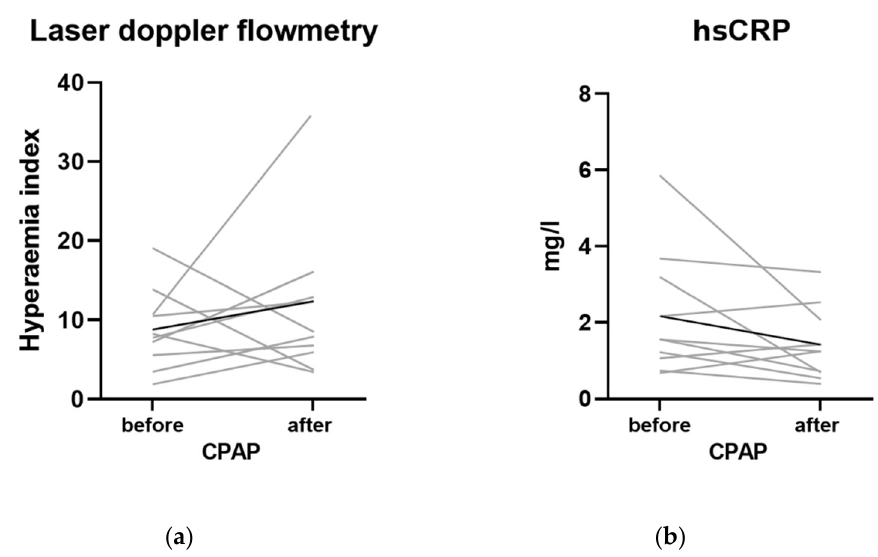
Figure 7. ( a , b ) The effect of 1-year CPAP therapy on hsCRP and endothelial function measured by laser doppler flowmetry.